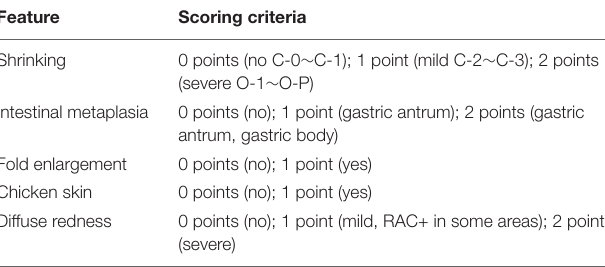
TABLE 1.1 | Endoscopic performance scoring criteria for gastric cancer risk. Feature